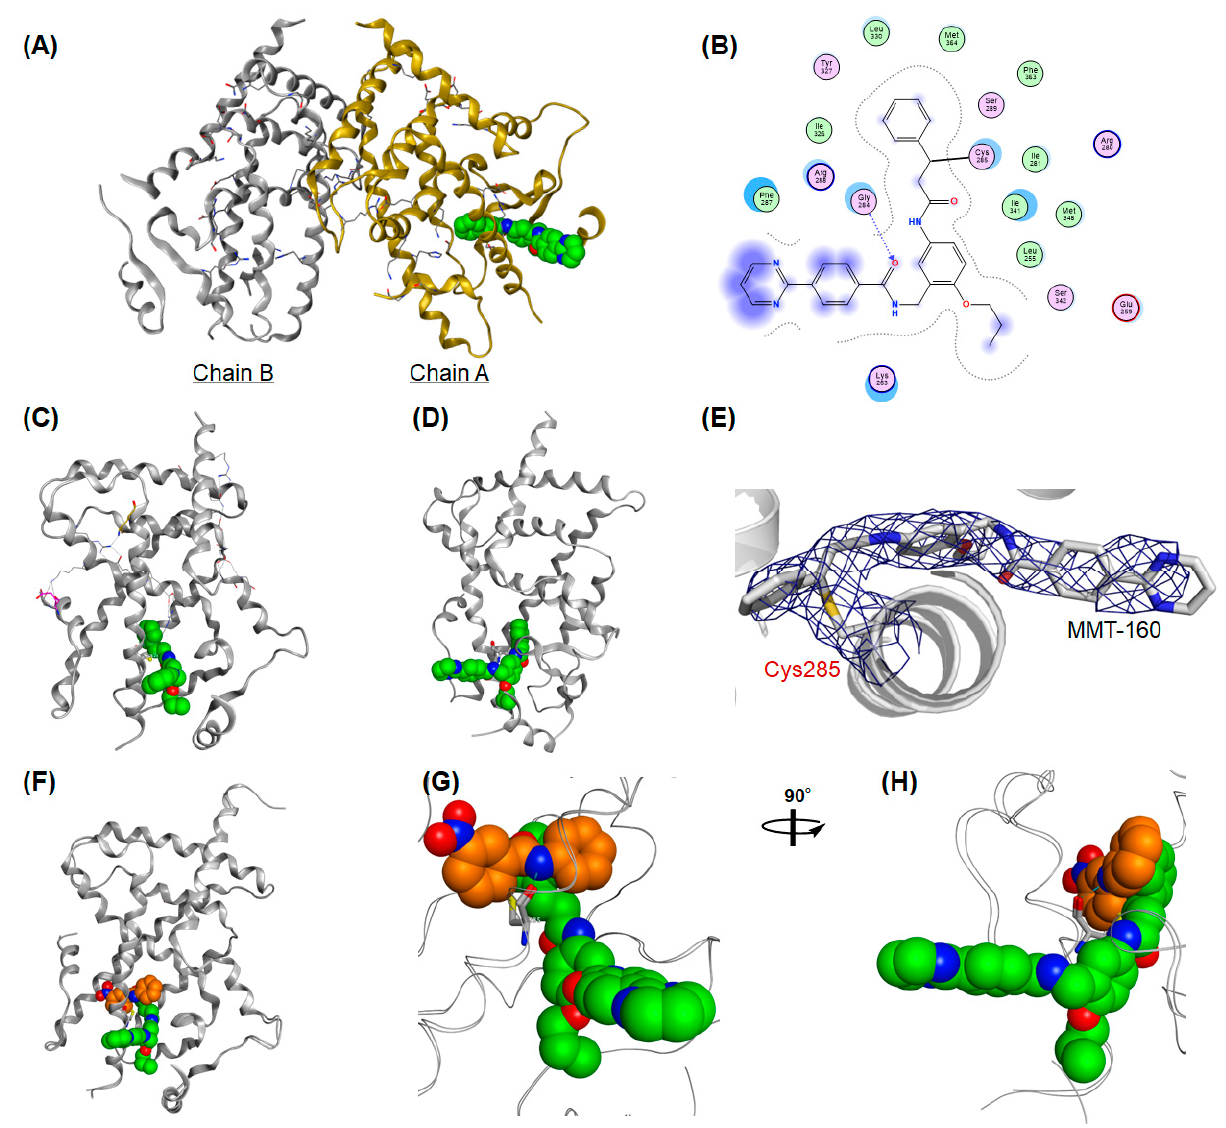
Figure 11. The binding mode of MMT-160 complexed with the hPPAR γ LBD. ( A ) Whole structure of the hPPAR γ LBD–MMT-150 homodimer (PDB: 7WOX). Proteins are represented as a gray and a yellow ribbon model and MMT-160 is depicted as a green van der Waals model. ( B ) Two-dimensional interaction map of the hPPAR γ LBD and MMT-150. ( C , D ) Whole structure of the non-full agonist form of hPPAR γ LBD–MMT-160. Proteins are represented as a van der Waals surface model and MMT-160 is depicted as a green van der Waals model. ( D ) Zoomed-in view of the covalent binding mode of MMT-160 to CYS285. ( E – H ) Superimposed structures of GW-9662 and MMT-160 docked into the hPPAR γ LBD. Proteins are represented as ribbon and wire models. GW-9662 is depicted as a brown van der Waals model and MMT-160 is depicted as a green van der Waals model.